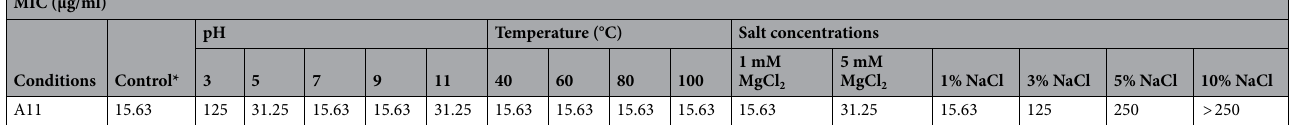
Table 4. MIC values (µg/ml) of A11 in the different environmental conditions against S. enterica serovar Typhimurium ATCC 13311. *Control MIC values were determined in the absence of those different environmental conditions.